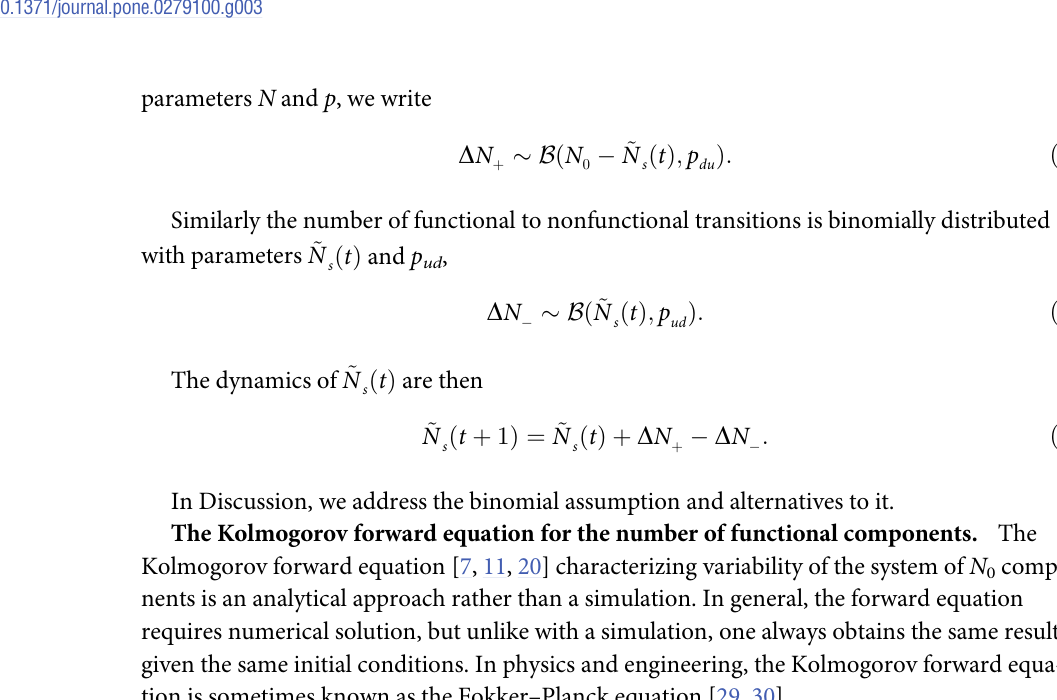
is that more components must be functional to achieve the same level of 50